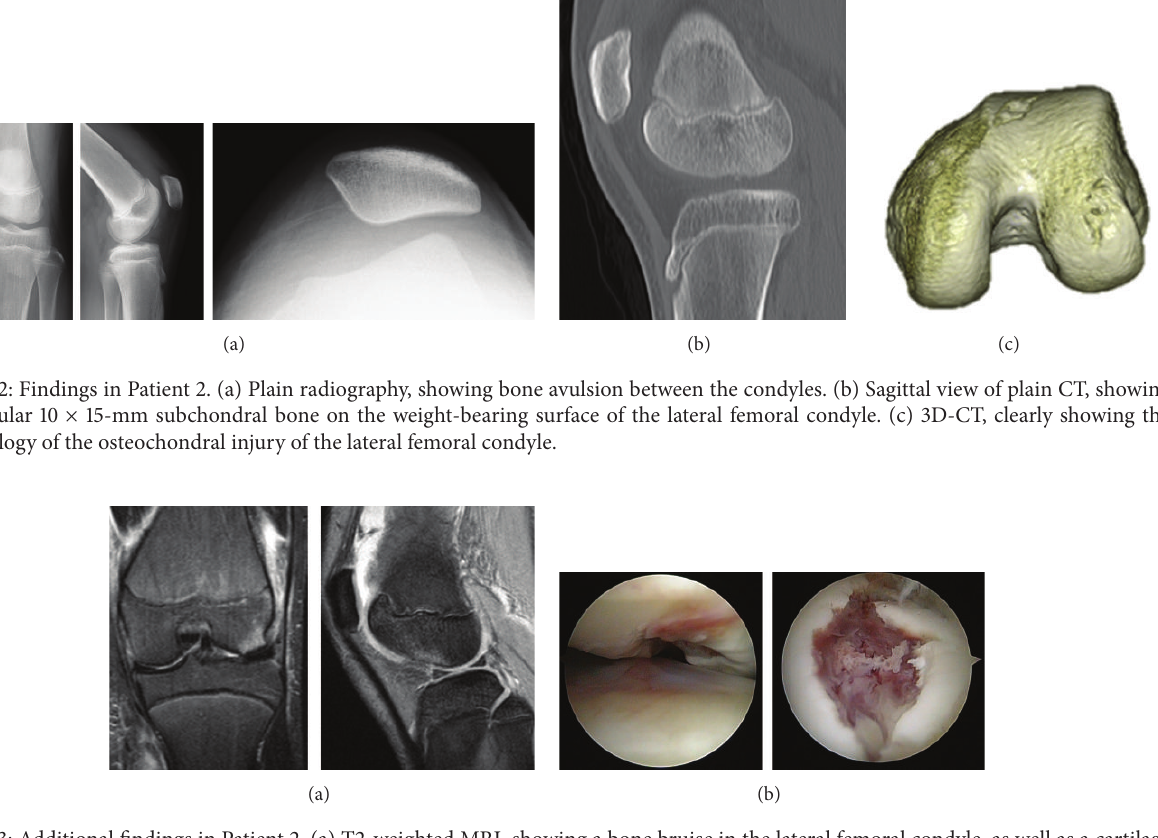
Figure 3: Additional findings in Patient 2. (a) T2-weighted MRI, showing a bone bruise in the lateral femoral condyle, as well as a cartilage defect of the lateral femoral condyle. (b) During extension of the knee joint, an osteochondral defect was observed in the joint surface of the weight-bearing portion of the lateral femoral condyle (left). At 90 ∘ flexion of the knee joint, a 10 × 15-mm osteochondral defect was clearly observed